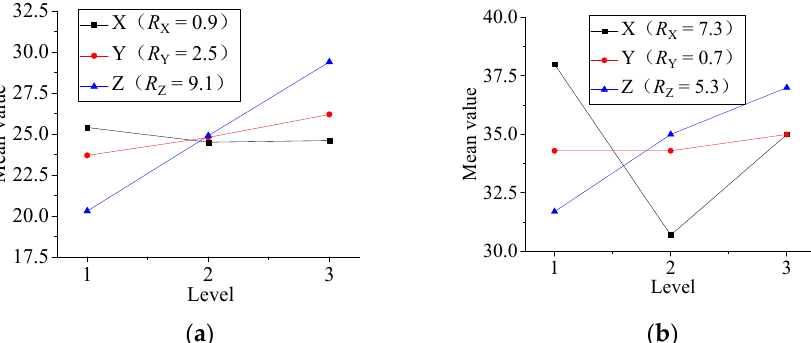
Figure 4. The relationship of etching rate, roughness and parameters. ( a ) Parameter range analysis of film etching rate; ( b ) Parameter range analysis of film roughness.